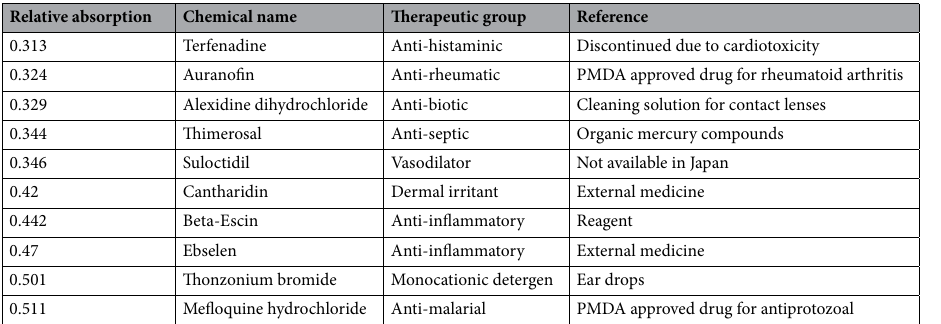
Table 1. Drugs with low desmoid cell proliferation rate, their therapeutic groups and reference points. PMDA, Pharmaceuticals and Medical Devices Agency.